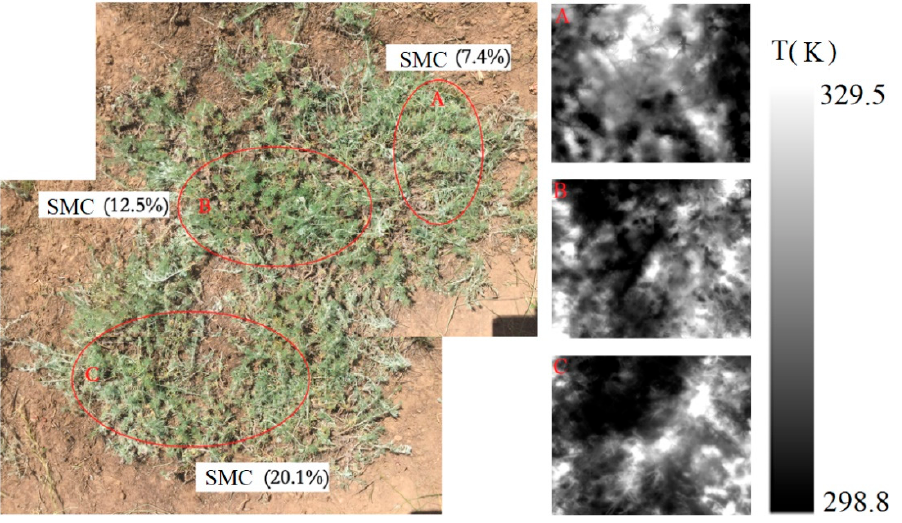
Figure 23. Temperature of Artemisia frigida .